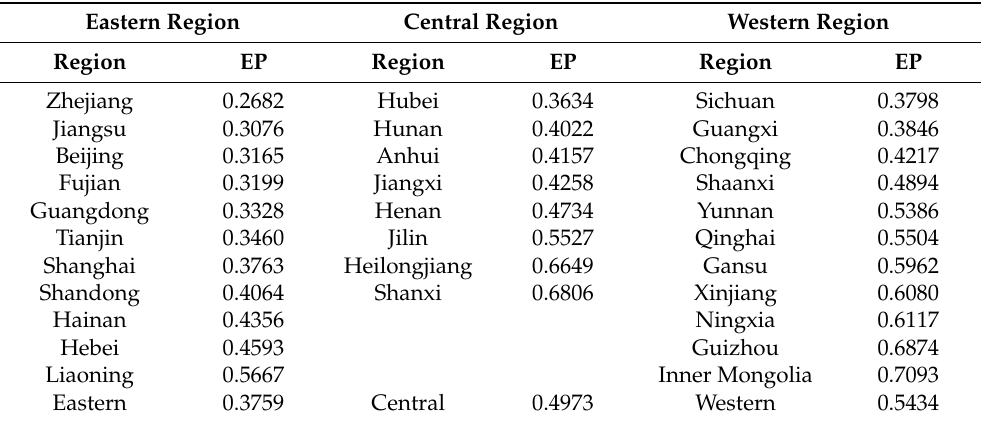
Table 2. EP in distinct